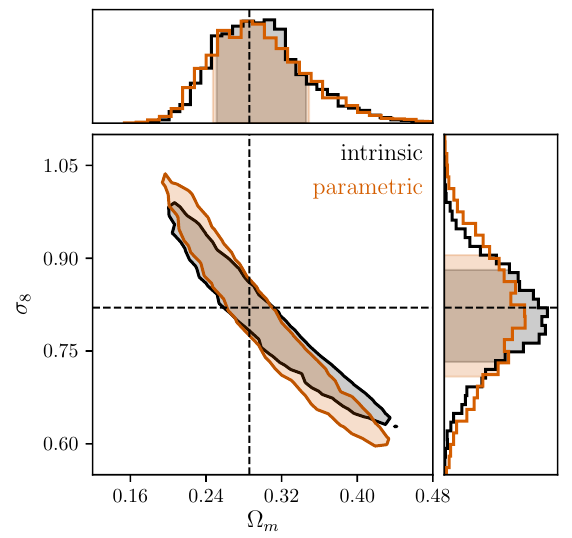
Figure 8. Constraints on the cosmology parameters Ω m and σ 8 . Shown are the two sigma joint contours and marginal distributions from the intrinsic redshifts ( black ), and using the best-fit paramet- ric efficiencies ( orange ). The degeneracy changes because para- metric efficiencies do not use the cosmology to convert redshifts to comoving